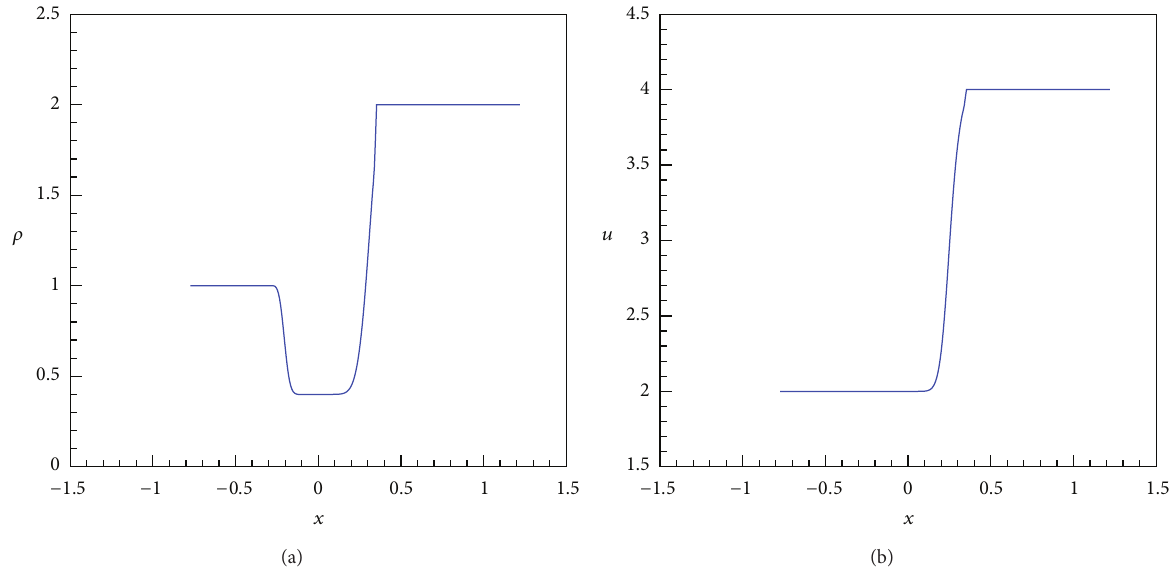
Figure 4: Numerical results for the case 𝑢 − < 𝑢 + + (1/𝜌 + ) at 𝑡 = 0.2 .